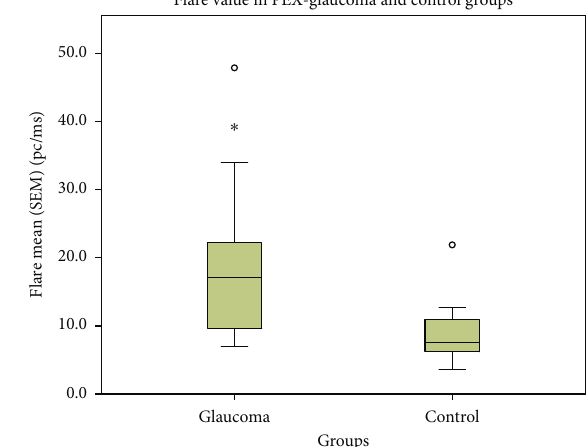
Figure 1: The graph shows aqueous humour flare mean (SEM) among glaucoma and control groups. The glaucoma group showed significantly higher aqueous humour flare than that of the control group ( p < 0 . 001, Mann–Whitney U test). PEX syndrome and aqueous humour flare.